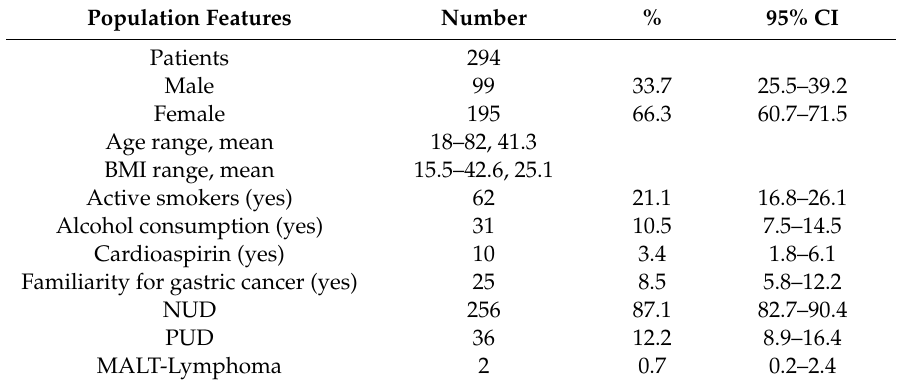
Table 1. Demographic and clinical characteristics of